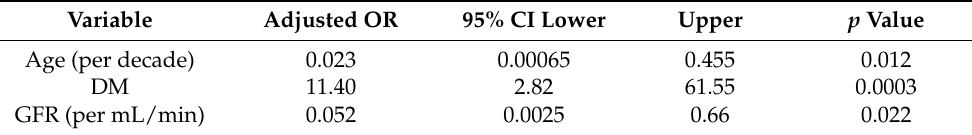
Table 3. Risk factors for a serum phosphate > 1.78 mmol/L, multivariable model.